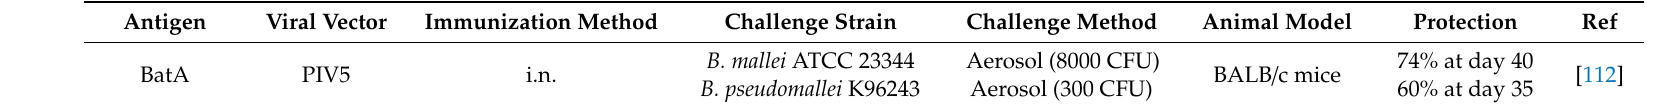
Table 6. Viral vector-based vaccines a